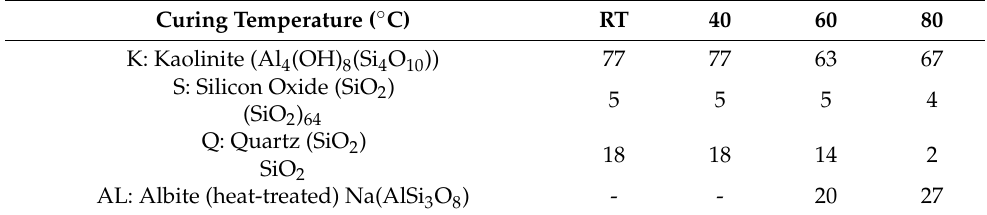
Table 1. Phase composition of the as-cured kaolin-GGBS geopolymer (%).